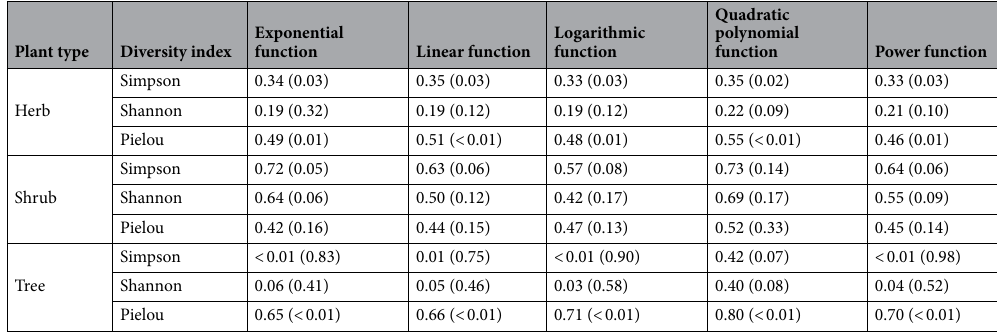
Table 1. Various functional relationships between species diversity and elevations. The α-Diversity indices used in this study were the Simpson index, Shannon index, and Pielou index. Data not presented in parentheses are the coefficients of determination of the equations, and data in parentheses are the P values of the significance testing of the equations. The numbers of data points are 80, 64, and 20 from sub-quadrats for the herb, shrub, and tree communities,